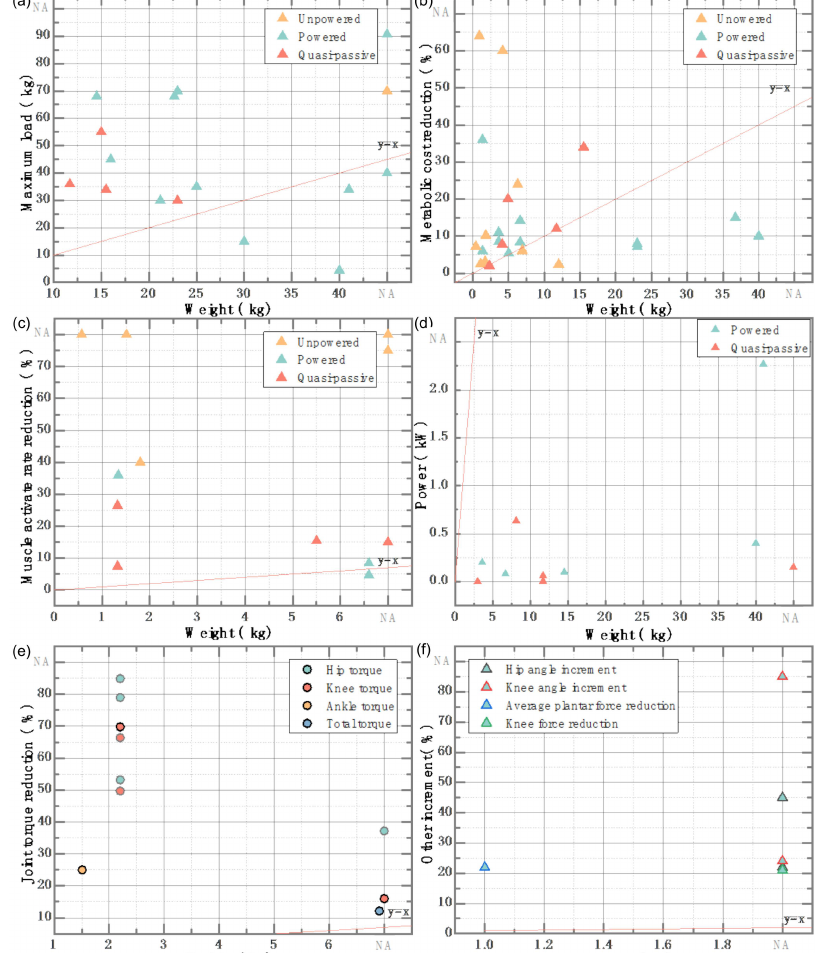
Figure 10. Relationship between weight and performance evaluation results. ( a ) maximum load with wearable exoskeleton. ( b ) the metabolic reduction with wearable exoskeleton, ( c ) muscle activate rate reduction with wearable exoskeleton, ( d ) device power for powered and quasi-passive exoskeleton, ( e ) joint toque reduction with the device, ( f ) other increment with wearable